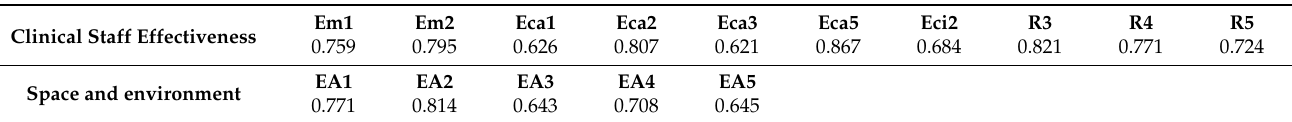
Table 3. Dimensions and item loadings of the variable perceived